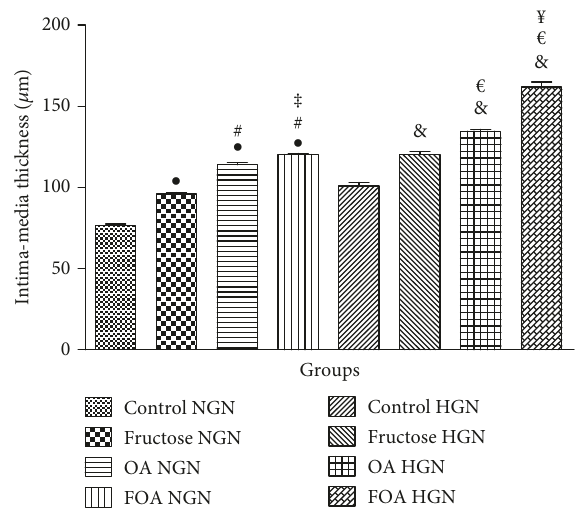
Figure 5: Intima media thickness. NGN: normogonadic; HNG: hypogonadic; OA: oxonic acid; FOA: fructose and oxonic acid. (cid:129) p < 0 0001 fructose, OA, and FOA NGN versus control NGN group. # p < 0 0001 OA and FOA NGN versus fructose NGN group. ‡ p < 0 0001 FOA NGN versus OA NGN group. & p < 0 0001 fructose, OA, and FOA HGN versus control HGN group. € p < 0 0001 OA and FOA HGN versus fructose HGN group. ¥ p < 0 0001 FOA HGN versus OA HGN